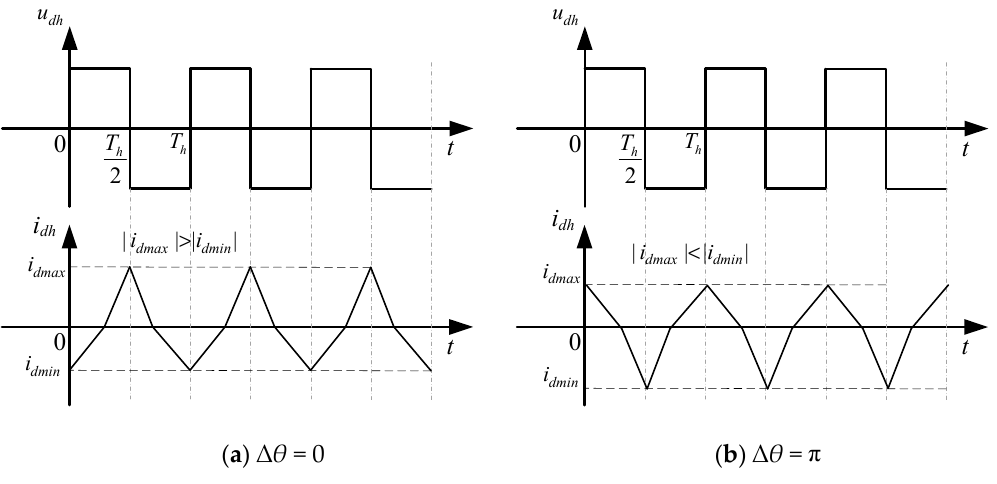
Figure 4. Ideal d -axis current waveform at different ∆θ .